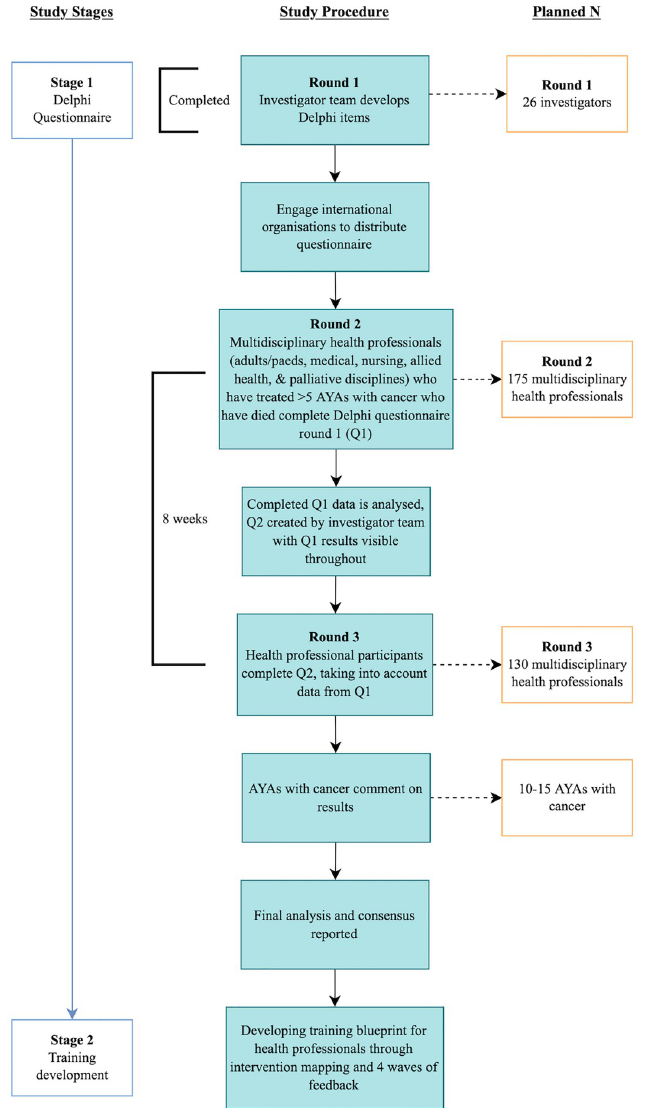
Fig 1. Flow chart to illustrate Delphi methodology